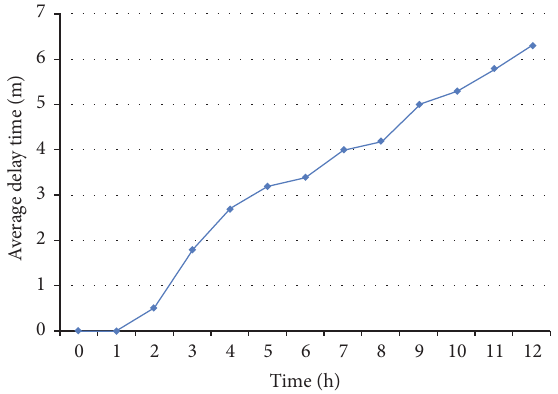
Figure 10: Average stop time variation against time.